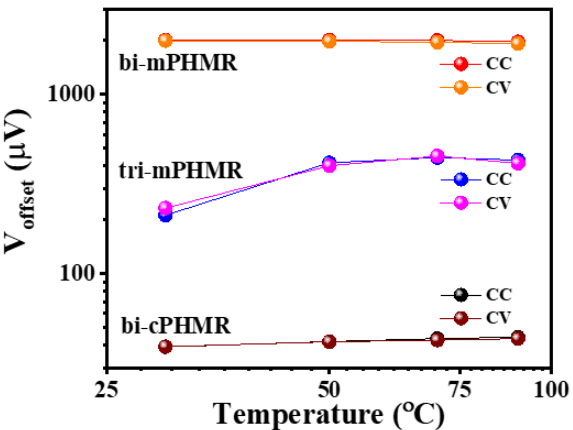
Figure 6. Sensors offset voltage variation with temperatures. Sensing current was 1 mA. Table 1. White noise decompositions at 100 Hz at 30 ◦ C and 90 ◦ C. The sensing current was 1 mA. Sensor Type 30 ◦